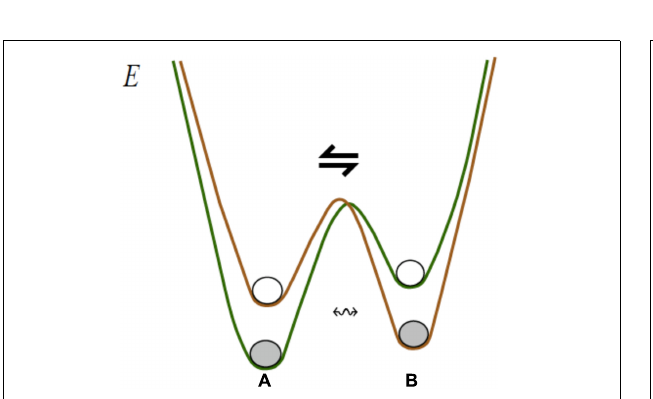
FIGURE 6 | The idea of assembly expresses the notion that groups of tightly associated neurons form cohesive units distinct from their surrounds in the network (associative links are not shown). The notion of a neuronal packet expresses, in the most general terms, a mechanism for forming and stabilizing such units in a material substrate (i.e., phase transition and emergence of an energy barrier in the interface between the phases). PRV A denotes “packet response vector.”